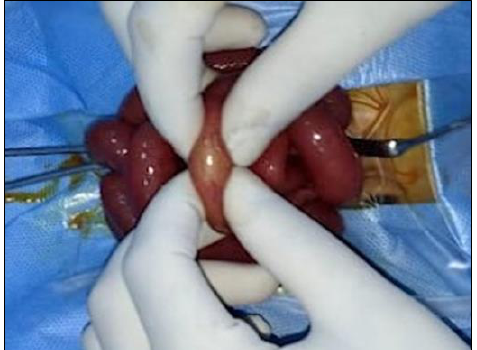
Figure 2: Intraluminal soft globular foreign body im- pacted in the distal ileum.